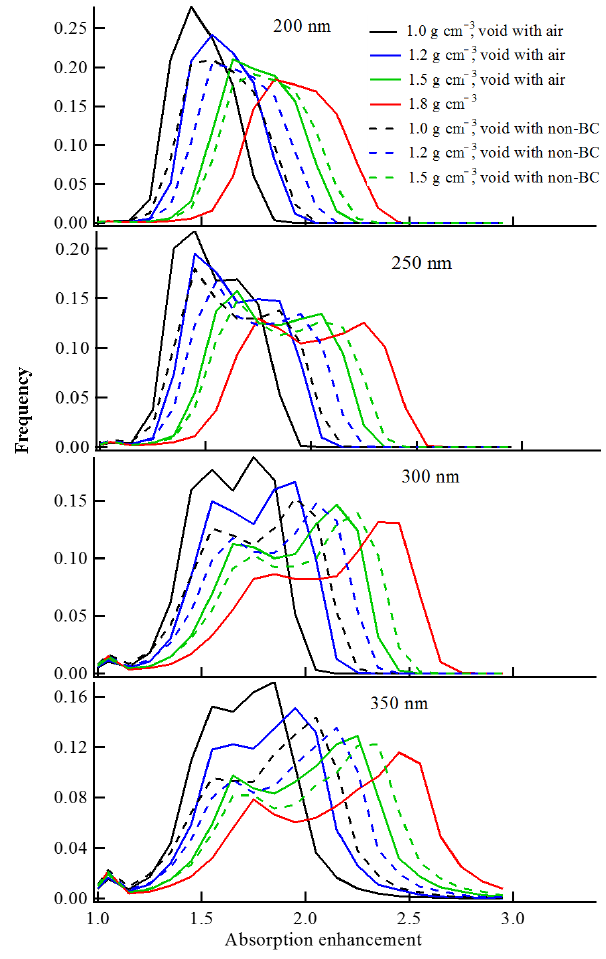
Figure 6. Absorption enhancement of size-resolved ambient In-BC particles with different core densities and void types.